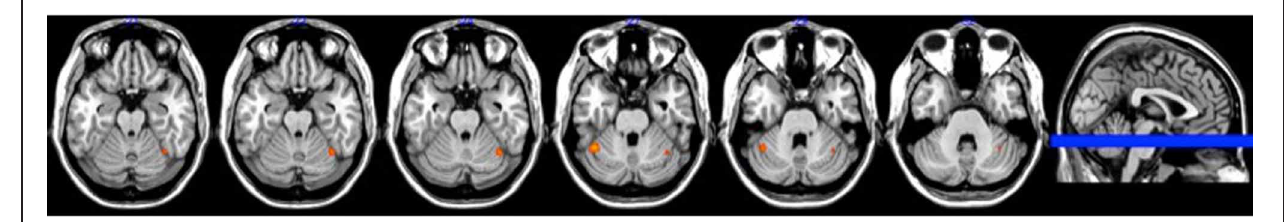
FIGURE 4 | Brain activation associated with overall movement error at retention ( p < 0 . 005).